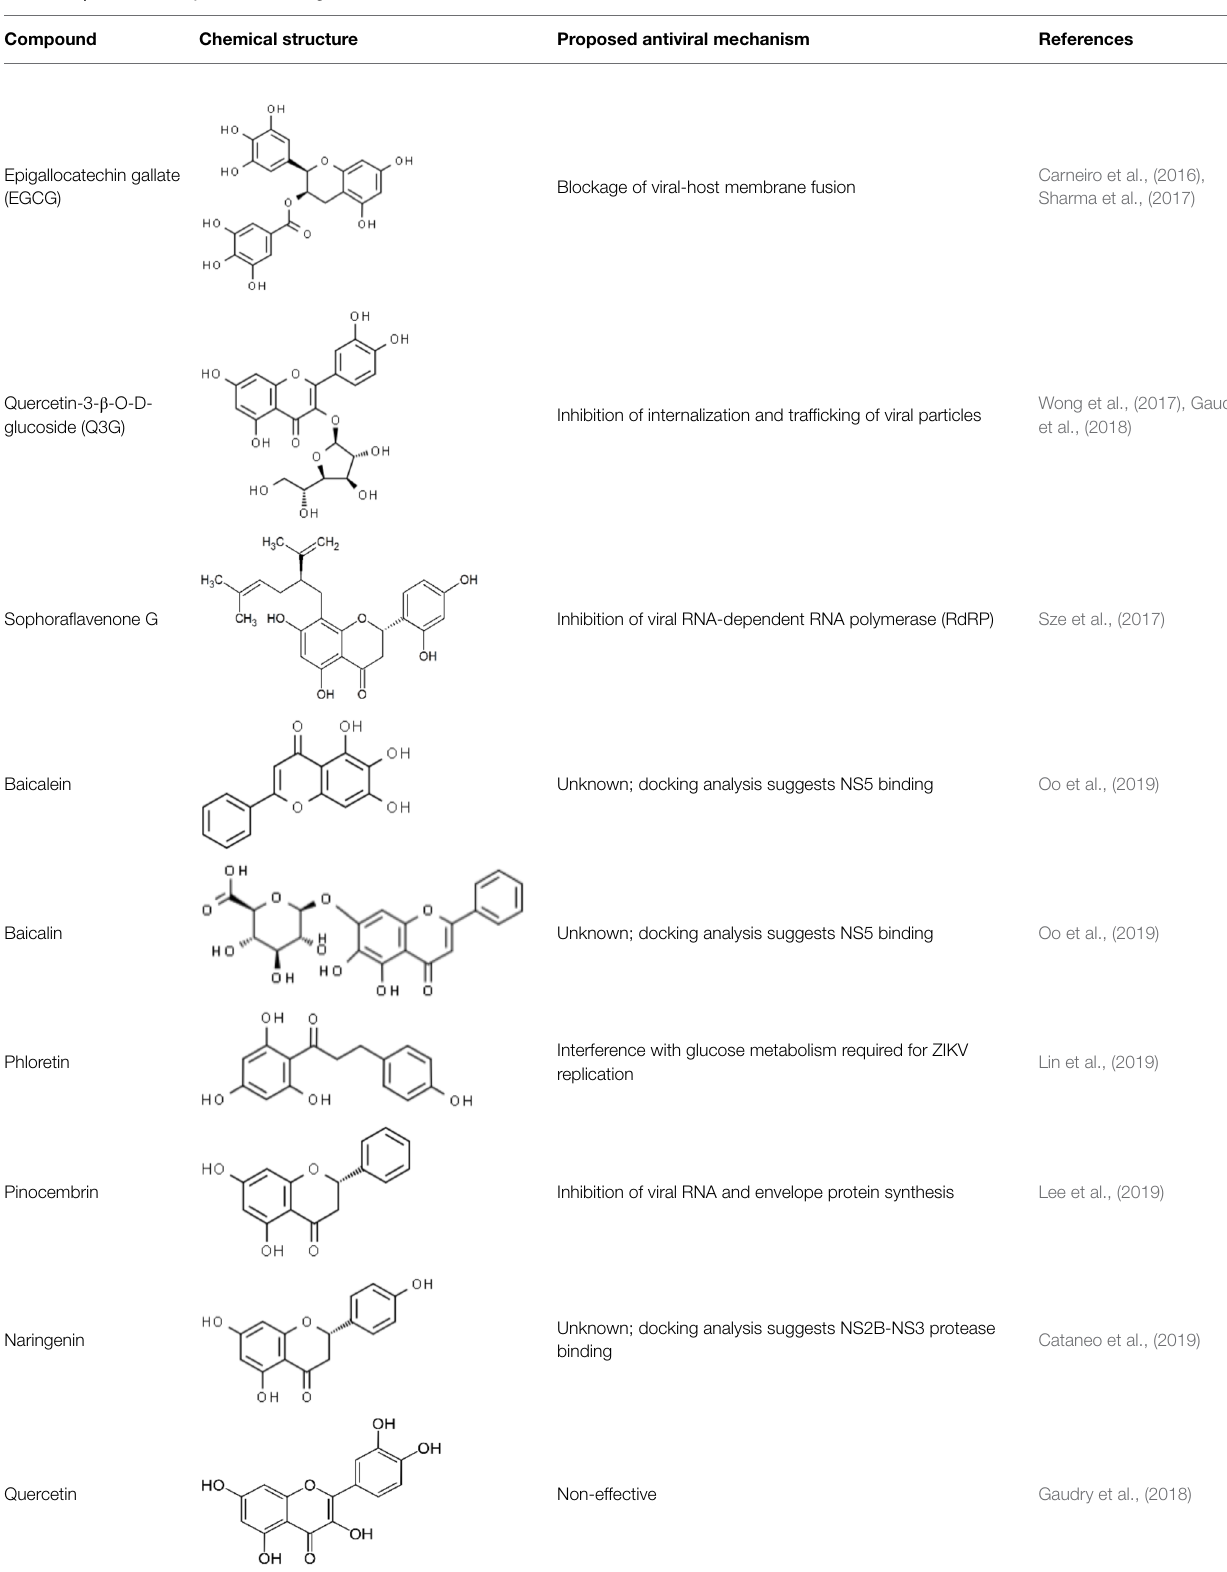
TABLE 1 | In vitro activity of flavonoids against